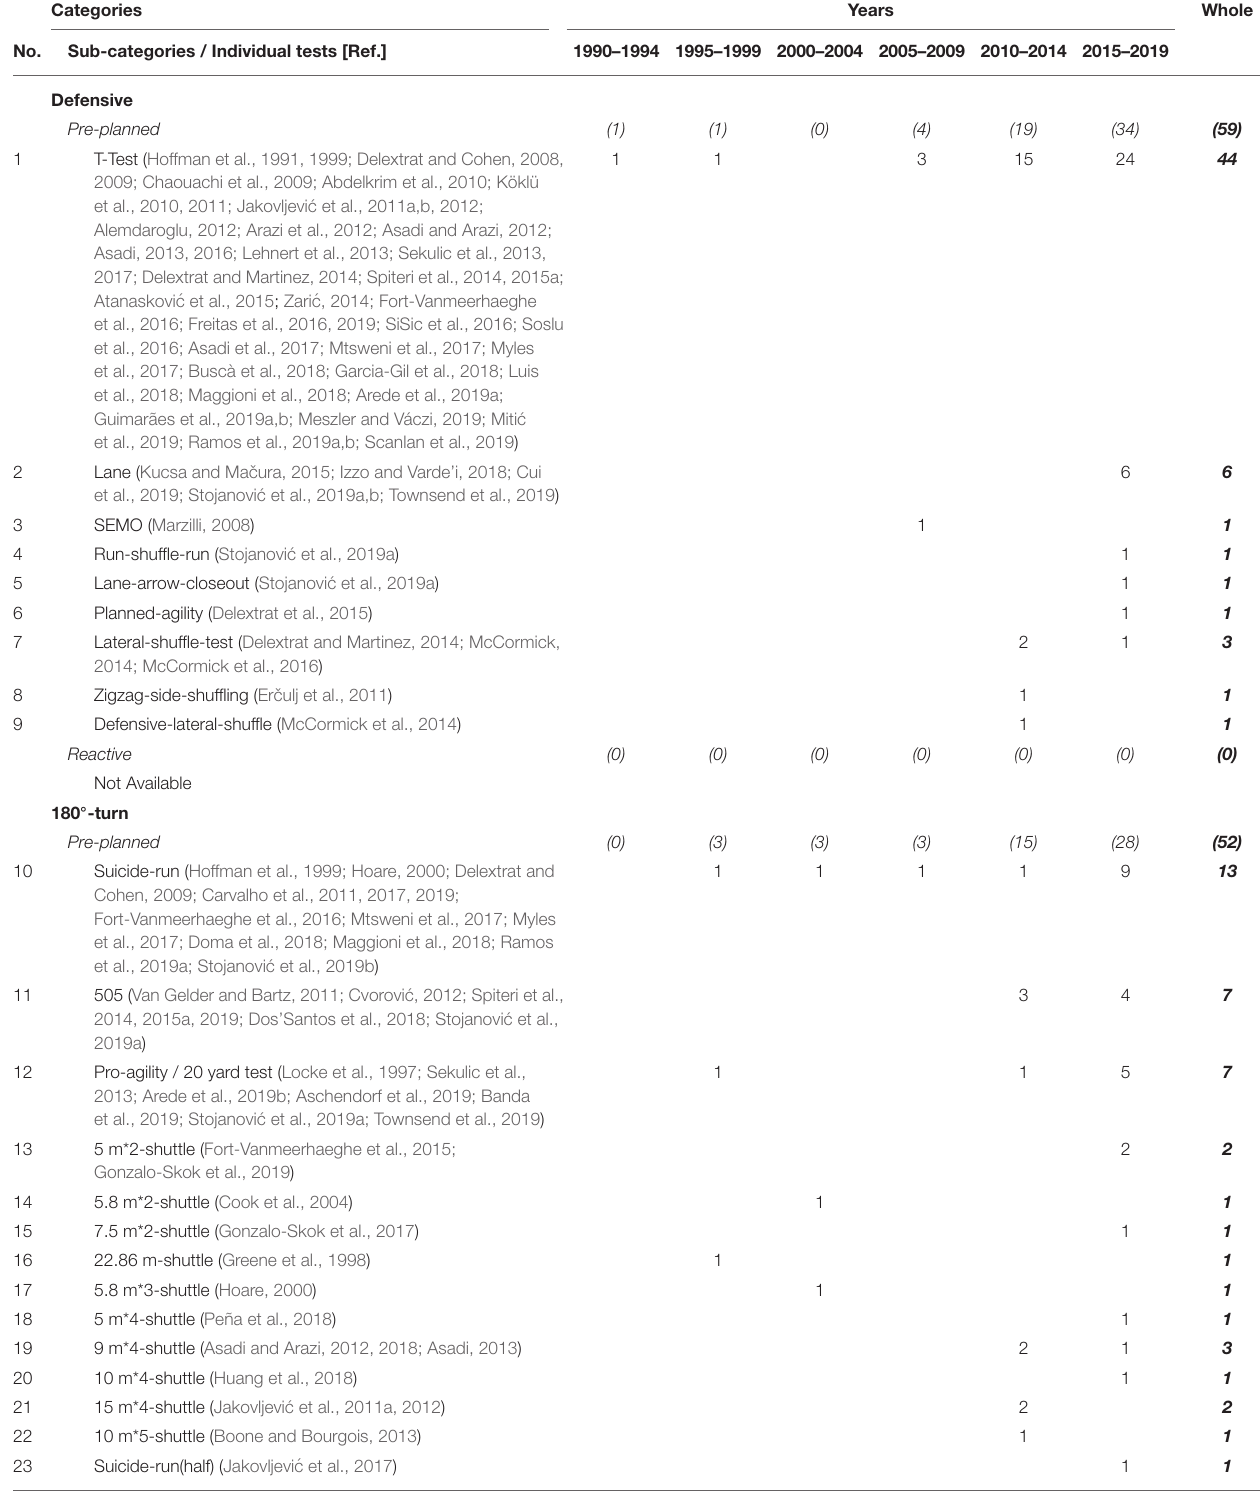
TABLE 1 | A list of CODS tests in basketball players and their numbers adopted from 1990 to 2019 shown at every five-year interval. Categories Years Whole No. Sub-categories / Individual tests